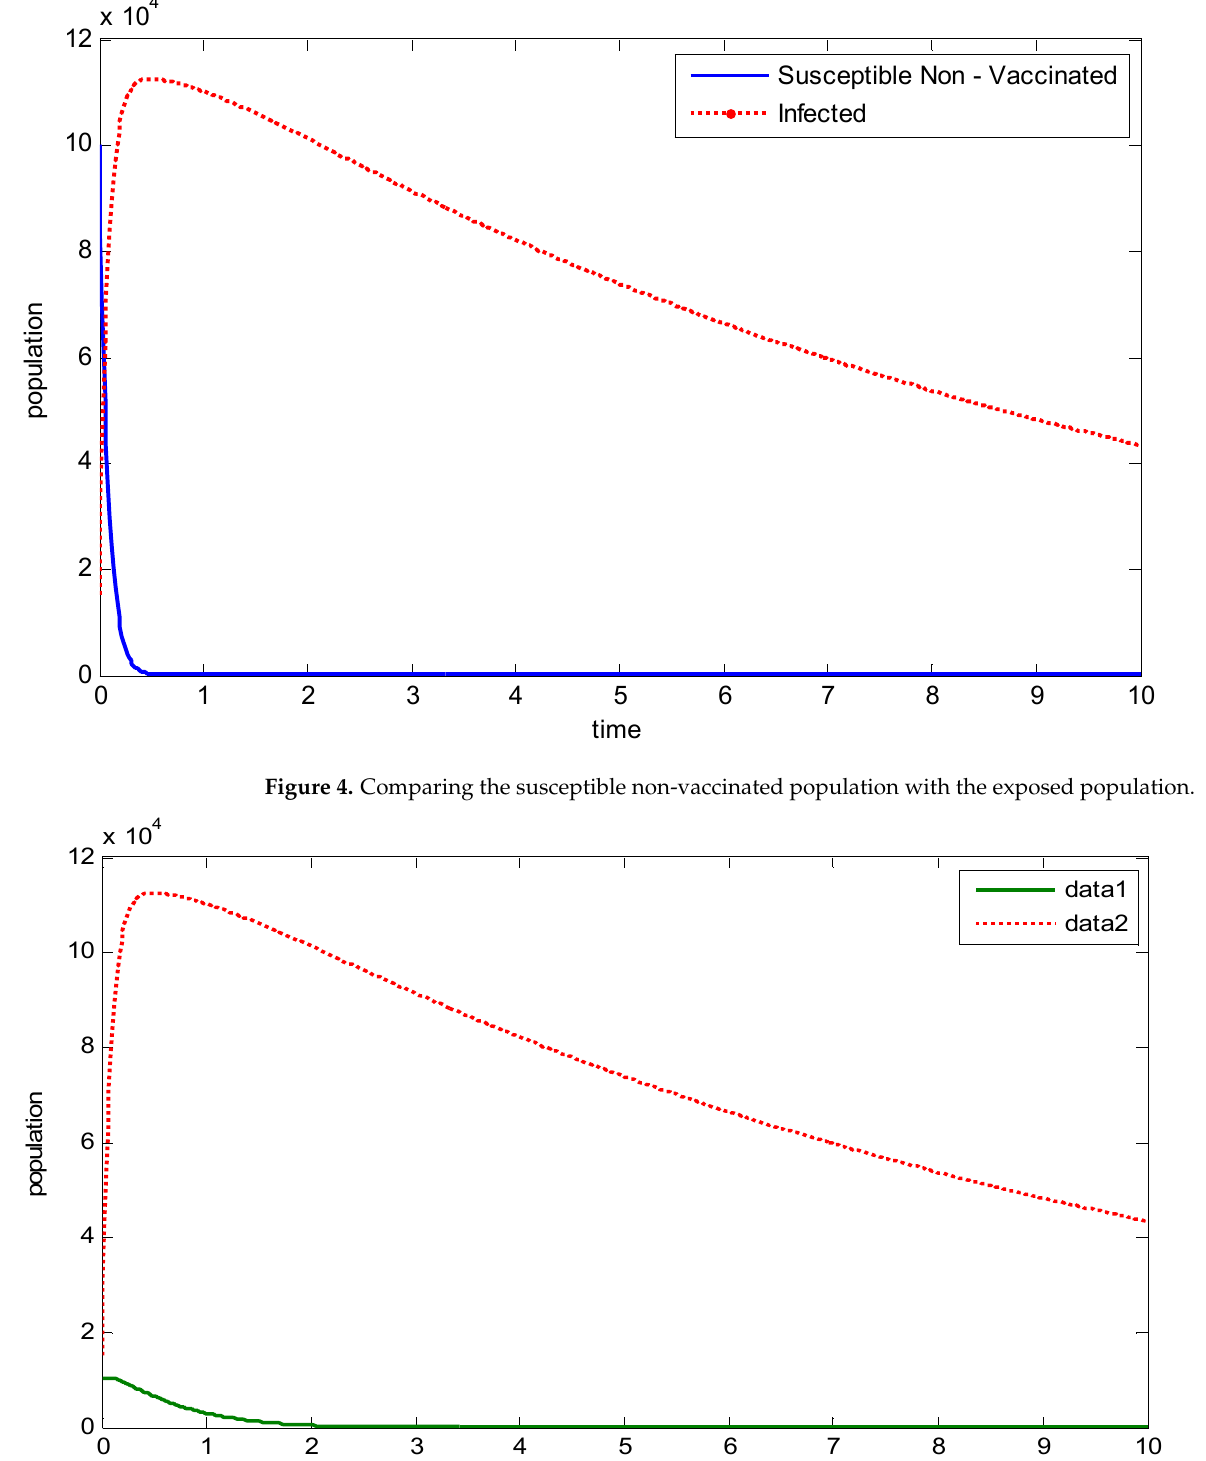
Figure 5. Comparing the susceptible vaccinated population with the exposed population.